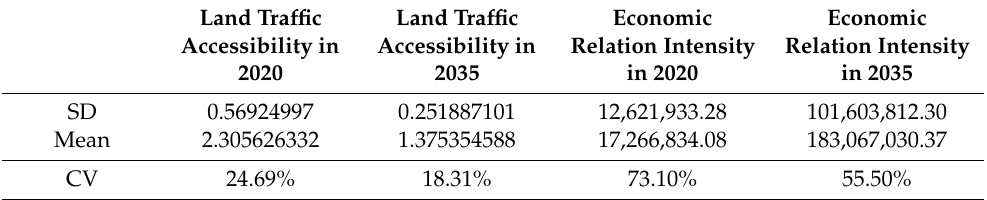
Table 3. Coefficient of variation between urban land traffic accessibility and economic relation intensity in Shandong Province,